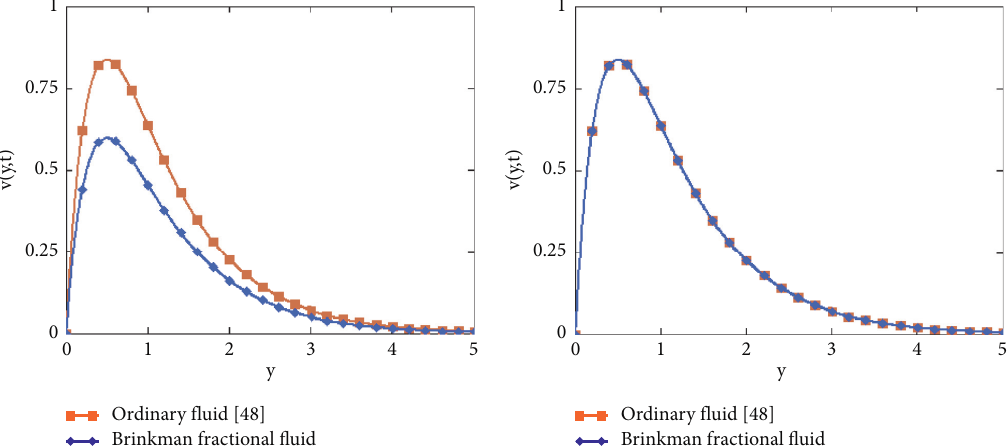
Figure 9: Velocity distribution for comparison of our work with Olisa [48].